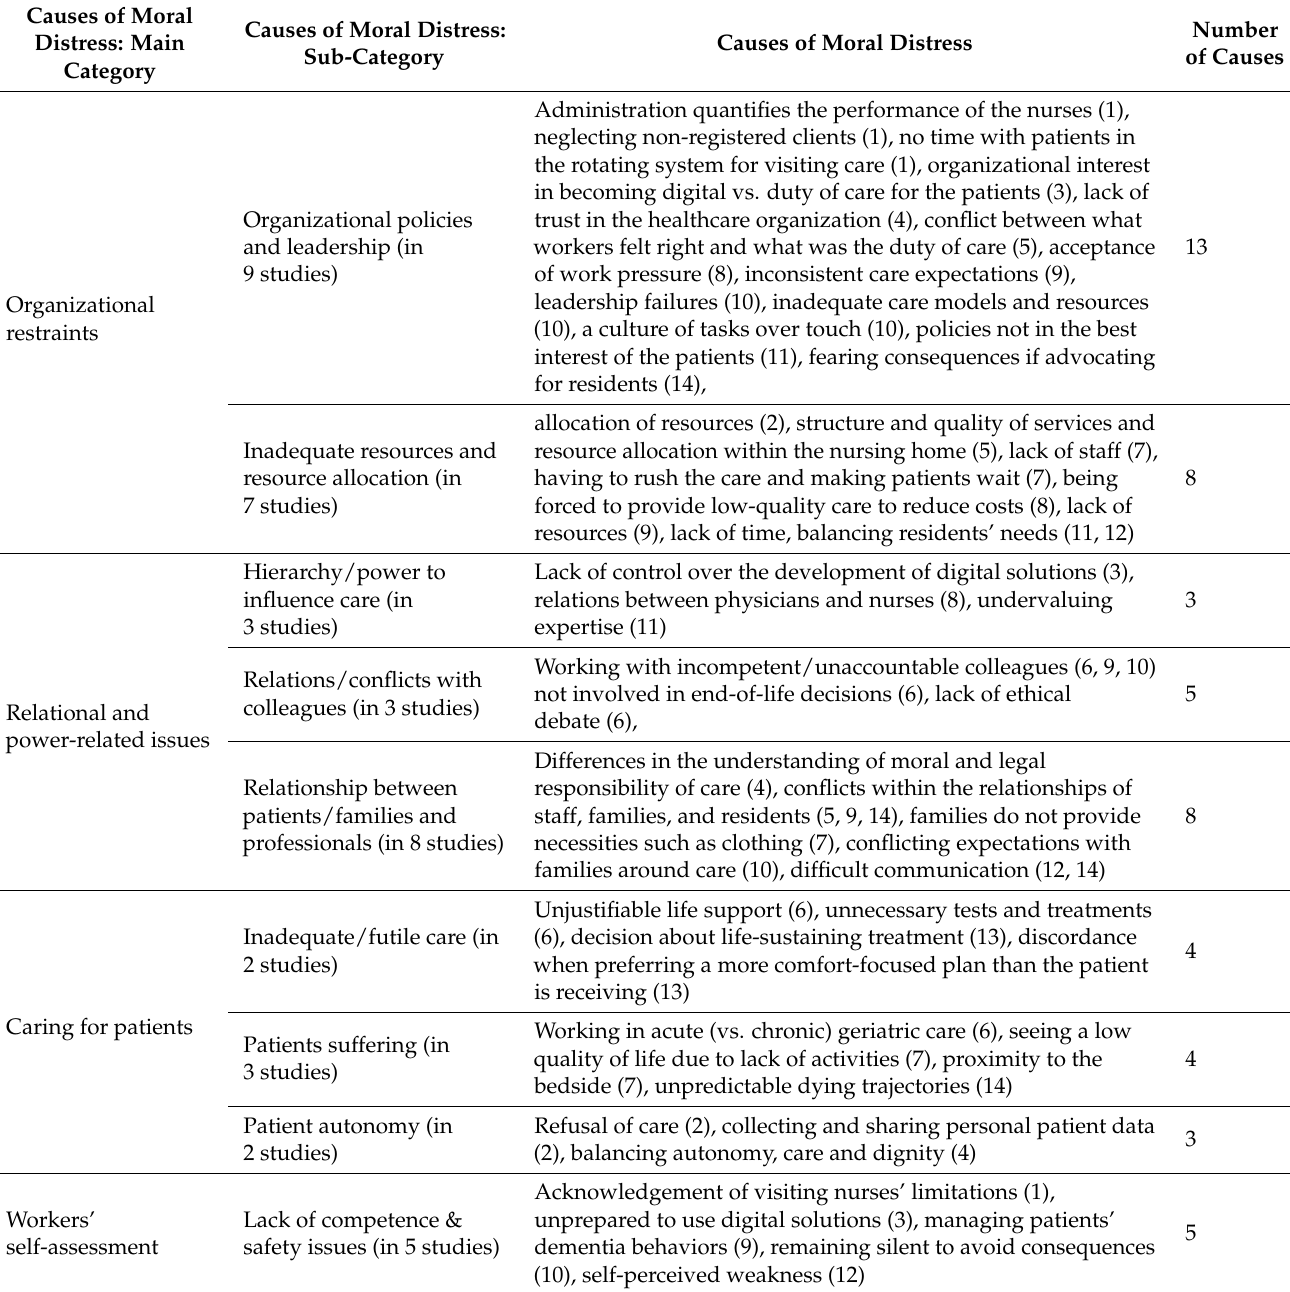
Table 2. Causes of moral issues and their categorizations identified in the included studies. Each study is indicated using study numbers in Table